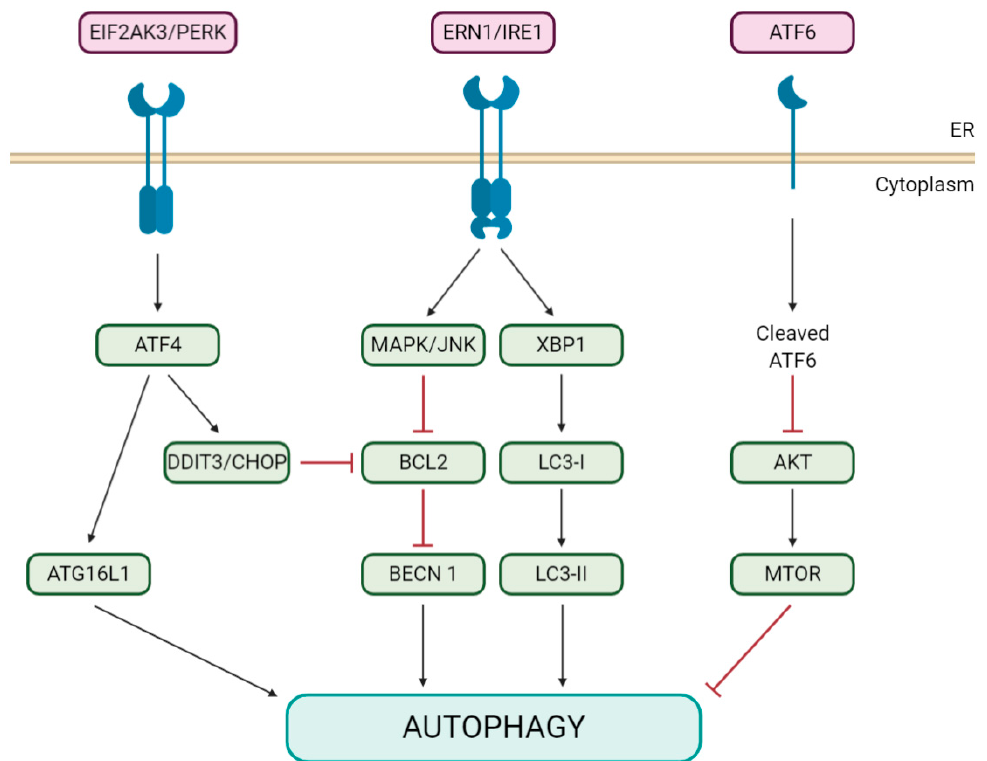
Figure 2. Diagram of the ER stress unfolded protein response (UPR) pathways triggering autophagy. ER stress can activate autophagy through three different UPR branches: EIF2AK3/PERK, ERN/IRE1 and/or the ATF6 signaling pathway. EIF2AK3/PERK induces autophagy by activating the ATG16L1 complex through ATF4 or by inducing DDIT3/CHOP expression, which indirectly causes BECN1 dissociation from BCL2. ERN/IRE1, through MAPK/JNK, mediates the phosphorylation of BCL2, which causes its dissociation from BECN1. The XBP1 branch enhances the formation of LC3-II. The ATF6 pathway also induces autophagy by inhibiting phosphorylation at the AKT-MTOR pathway.